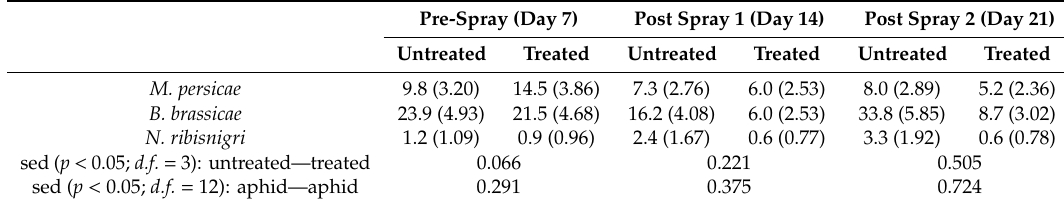
Table 11. Mean total number of M. persicae , B. brassicae , and N. ribisnigri nymphs recorded per plant after two treatments with Botanigard ES in field experiment 2 (square root-transformed data are given in parentheses). Applications of Botanigard were done on days 7 and 14 after inoculation of plants with aphids. Counts of aphid numbers were done immediately prior to spraying on day 7 and day 14, and 7 days after the second spray ( = day